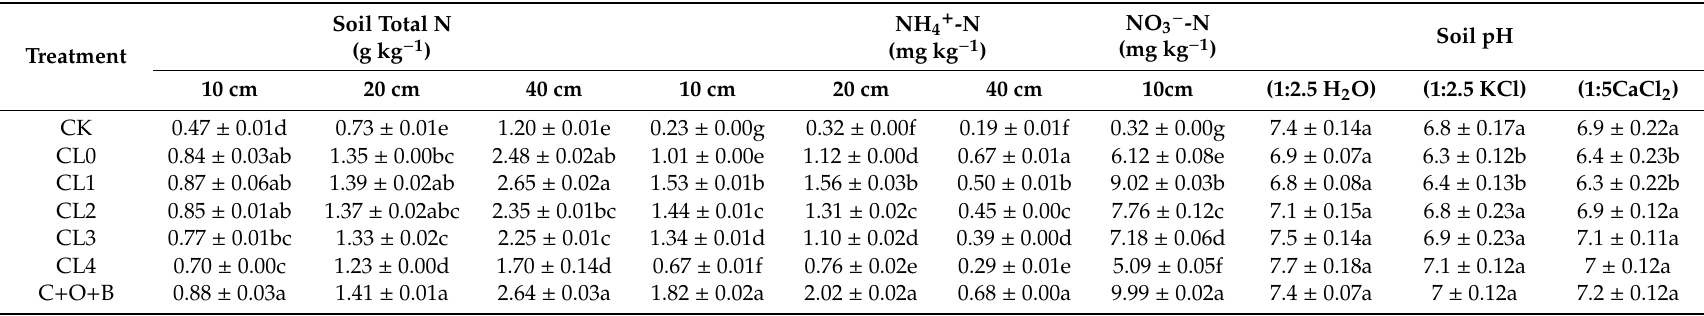
Table A1. Analysis of soil chemical properties after harvesting of winter wheat in North China Plain (NCP) experimental site during years 2017 / 2018, soil pH, Soil total nitrogen, NH 4 + -N, and NO 3 − -N at di ff erent soil depths under di ff erent fertilizer